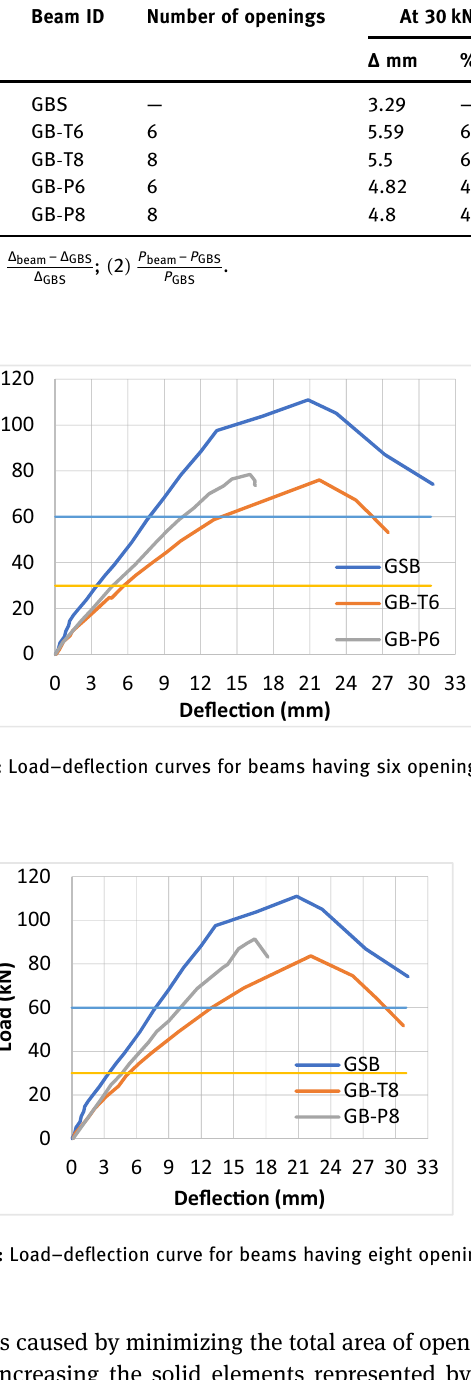
sti ff ness caused by minimizing the total area of openings while increasing the solid elements represented by the beams with various opening con fi gurations ( post inclina - tions ) , but with the same number of openings of six and eight, respectively.